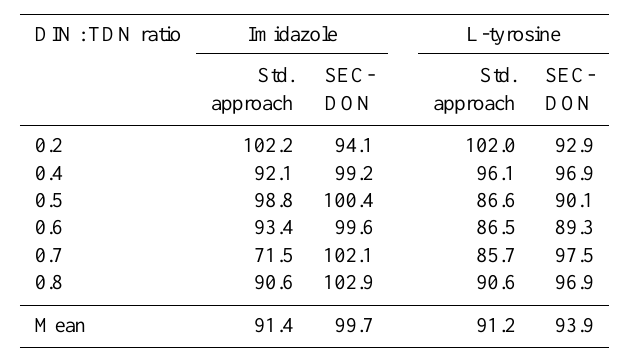
Table 3. Recovery rates (%) of DON standard compounds deter- mined by the standard approach (Std. approach: HTCO-TDN mi- nus NO − , 6 measurement replicates) and SEC-DON measurements 3 (2 measurement replicates) for L-tyrosine and imidazole at differ- ent DIN:TDN ratios, adjusted by the addition of NO − Table 1 for further details on the samples.